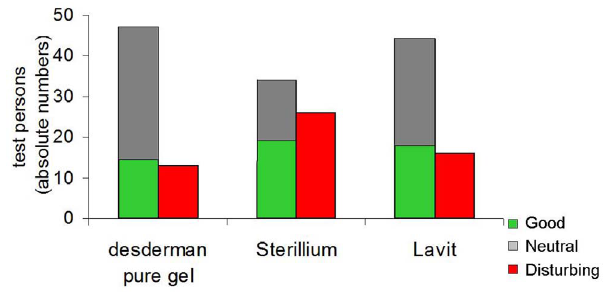
Figure 6. Number of participants that evaluated the odour of the three disinfectants as good (green), neutral (grey) or disturbing (red). The odour of desderman pure gel, Sterillium and Lavit were evaluated as good by 14, 19 and 18 persons, as neutral by 33, 15 and 26 persons and as disturbing by 13, 26 and 16 persons,